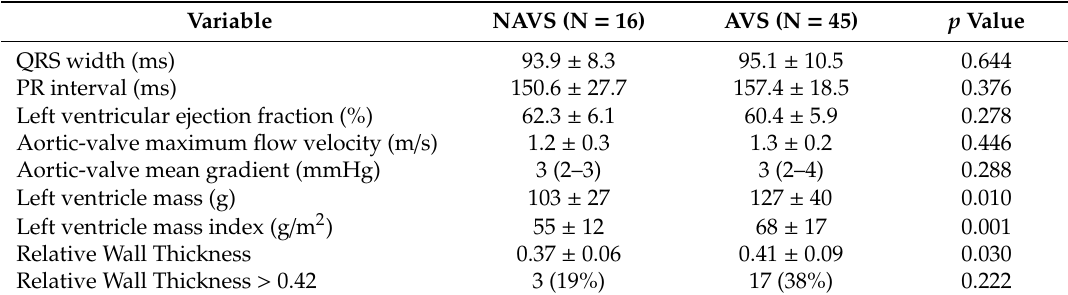
Table 2. Indices from echocardiogram and